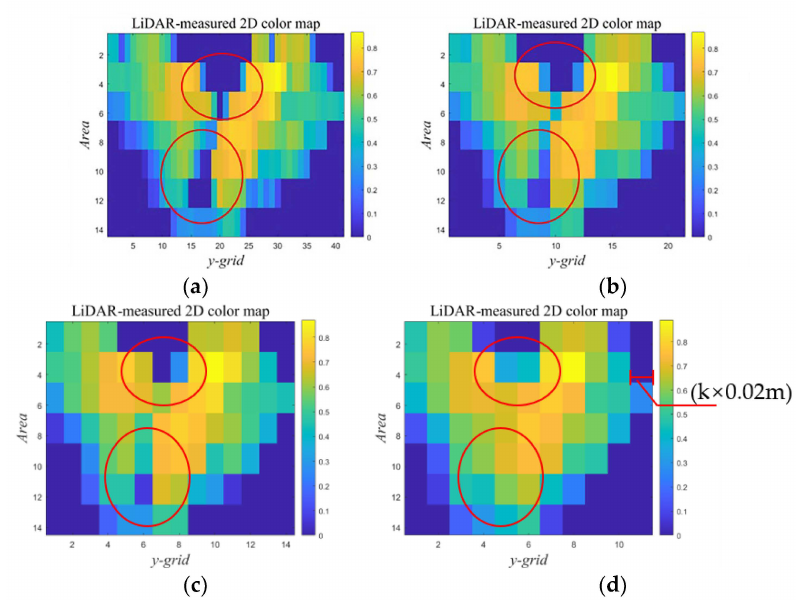
Figure 9. 2D depth colour map of canopy LiDAR detection under different mesh widths: ( a ) k = 2; ( b ) k = 4; ( c ) k = 6; ( d ) k = 8. Note: The red circles in the figure refer to the grid with the depth of 0 inside the canopy.